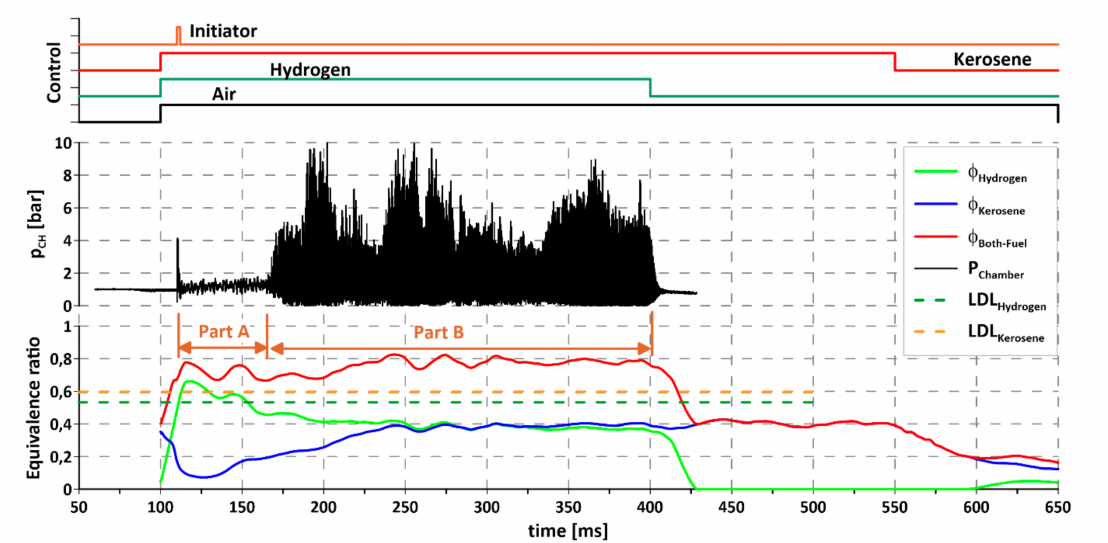
Figure 6. Propagation of rotating detonation for kerosene–air mixture, influence of hydrogen addition.